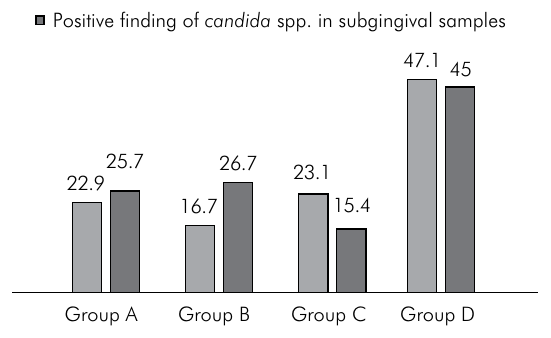
Figure 1. Presence of Candida spp. on tongue and in subgingival